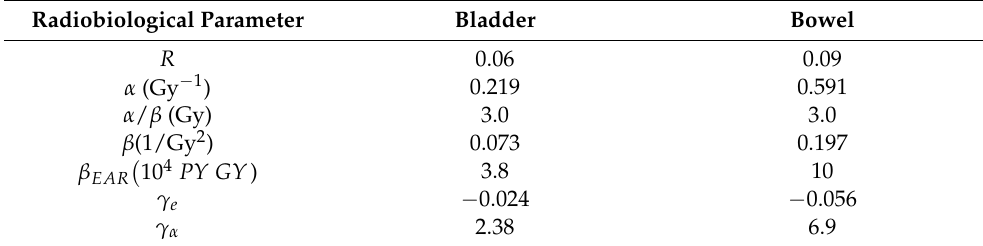
Table 2. Organ-specific radiobiological model parameters used for the calculation of OED and EAR for developing radiation-induced second cancer in the bowel and bladder. The model parameters correspond to carcinoma